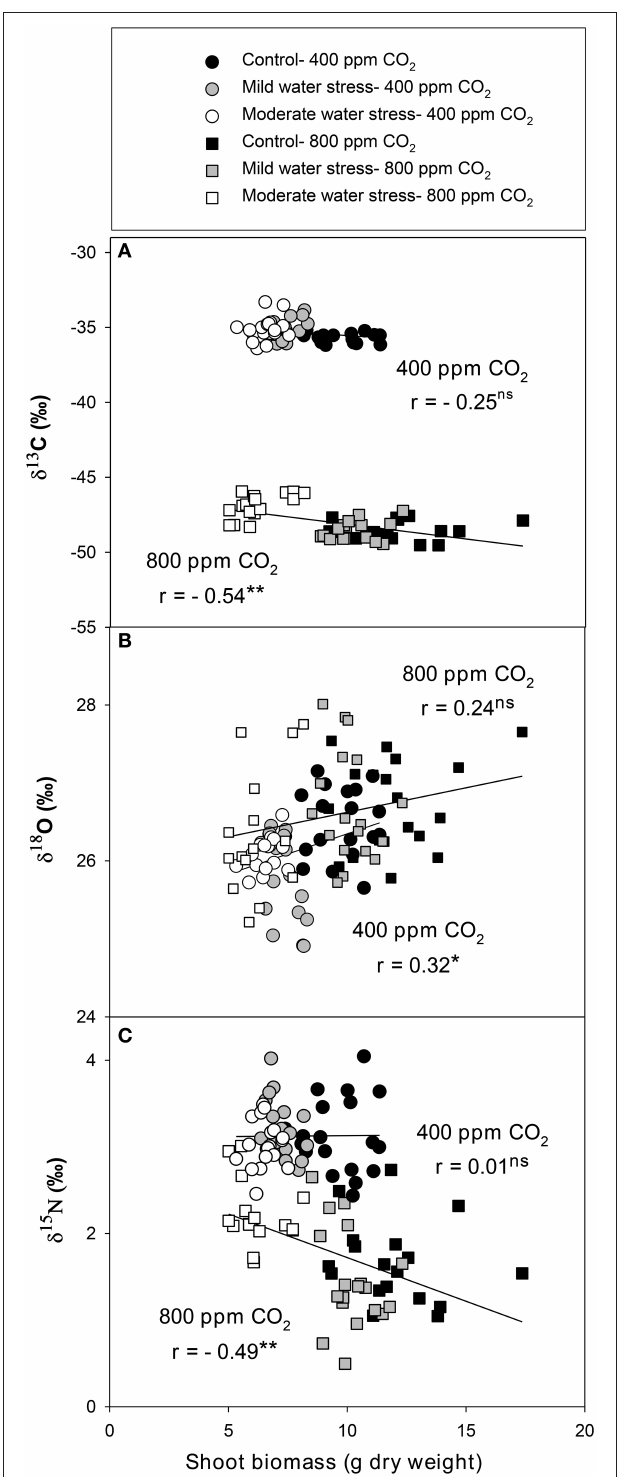
FIGURE 1 | Relationships of shoot biomass with the stable isotope compositions of (A) carbon ( δ 13 C), (B) oxygen ( δ 18 O), and (C) nitrogen ( δ 15 N) analyzed in the leaves of sweet pepper grown hydroponically under different [CO 2 ] and water regimes. Levels of significance: ns, no significant; * P < 0.05 and ** P < 0.01.